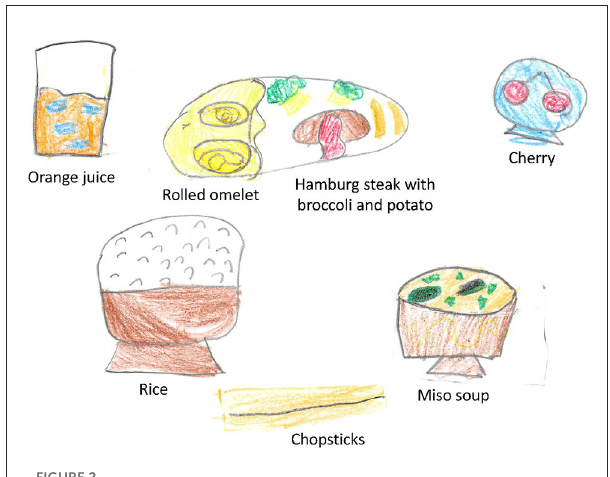
FIGURE2 Typical drawing of items in the “home” group.